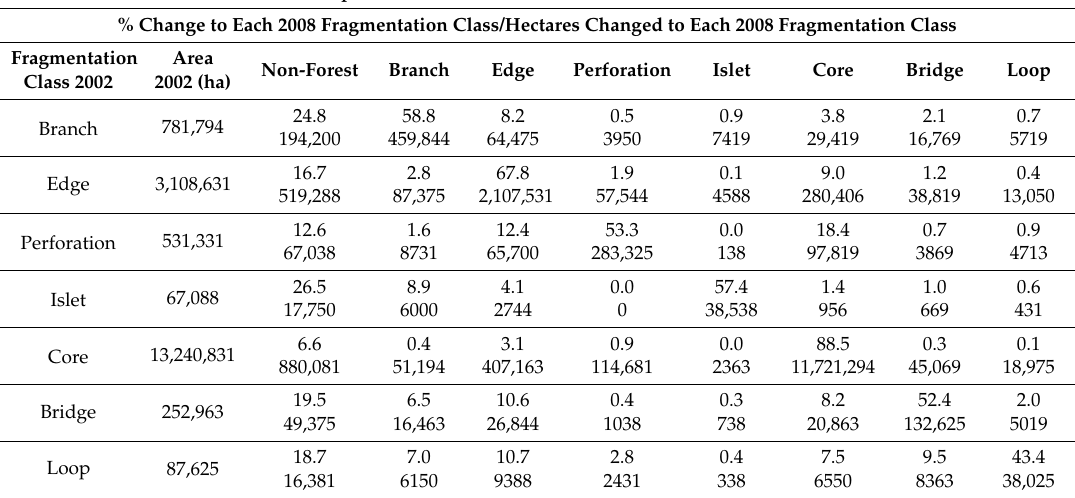
Table B1. Fragmentation classes transition matrices for tropical forest in the 2002–2008 period without differentiating between internal and external classes.